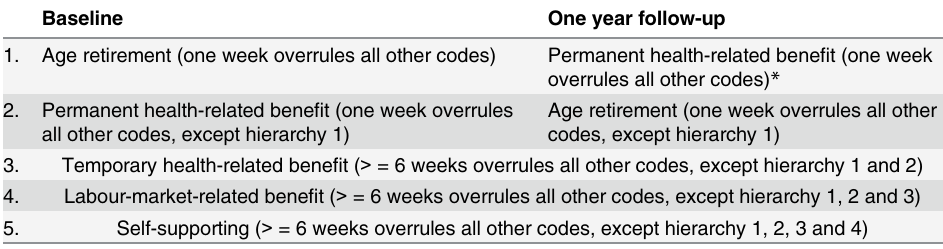
Table 2. Hierarchies of the categorization of provisional situation at baseline and one year follow-up. Baseline